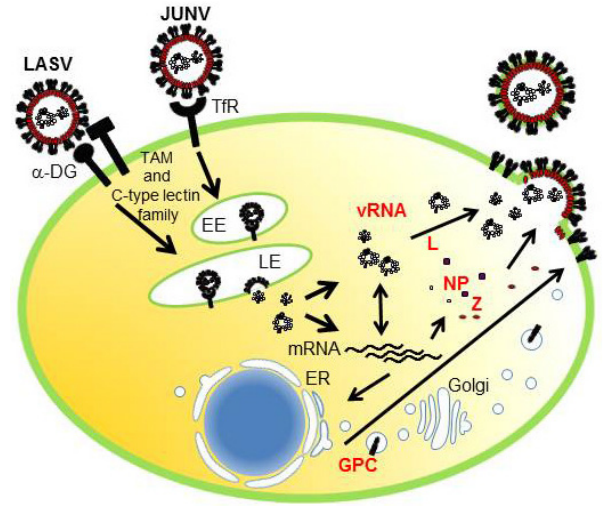
Figure 3. Life cycle of Arenavirus. LASV and JUNV use α -DG and TfR1, respectively, as the primary receptor. LASV also uses TAM family (Axl and Tyro3) and C-type lectin family (DC-SIGN and LSECtin) as receptors. JUNV enters the host cell by clathrin- mediated endocytosis, delivered to the Early endosome (EE) followed by the Late endosome (LE), while LASV enter cells by bypassing EE and reaches to the LE for the subsequent fusion process. Once vRNP is released into the cytoplasm, the viral genome is transcribed and replicated for vRNA and mRNA production. GPC is transported through the endoplasmic reticulum (ER) and Golgi compartments, where it is processed by S1P/SKI-1. Translated NP, L, and Z are transported to the platform for virus budding, gathered together with vRNP and cleaved GP, and then pinched off from the surface of infected